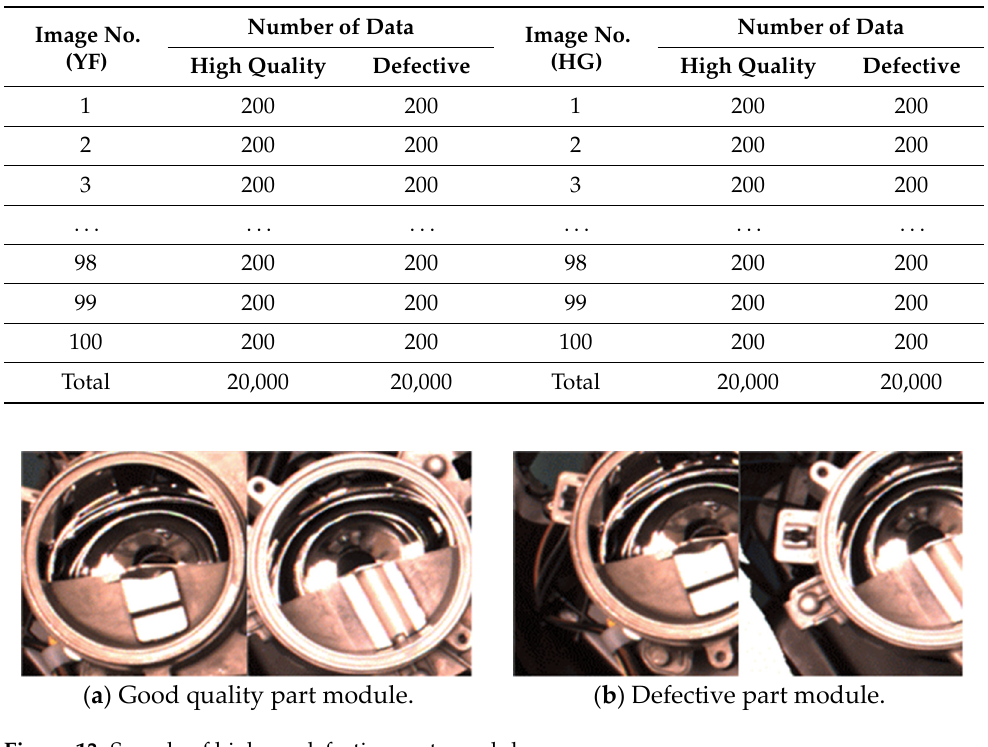
Figure 13. Sample of high vs. defective parts module. Table 3. Total data set.